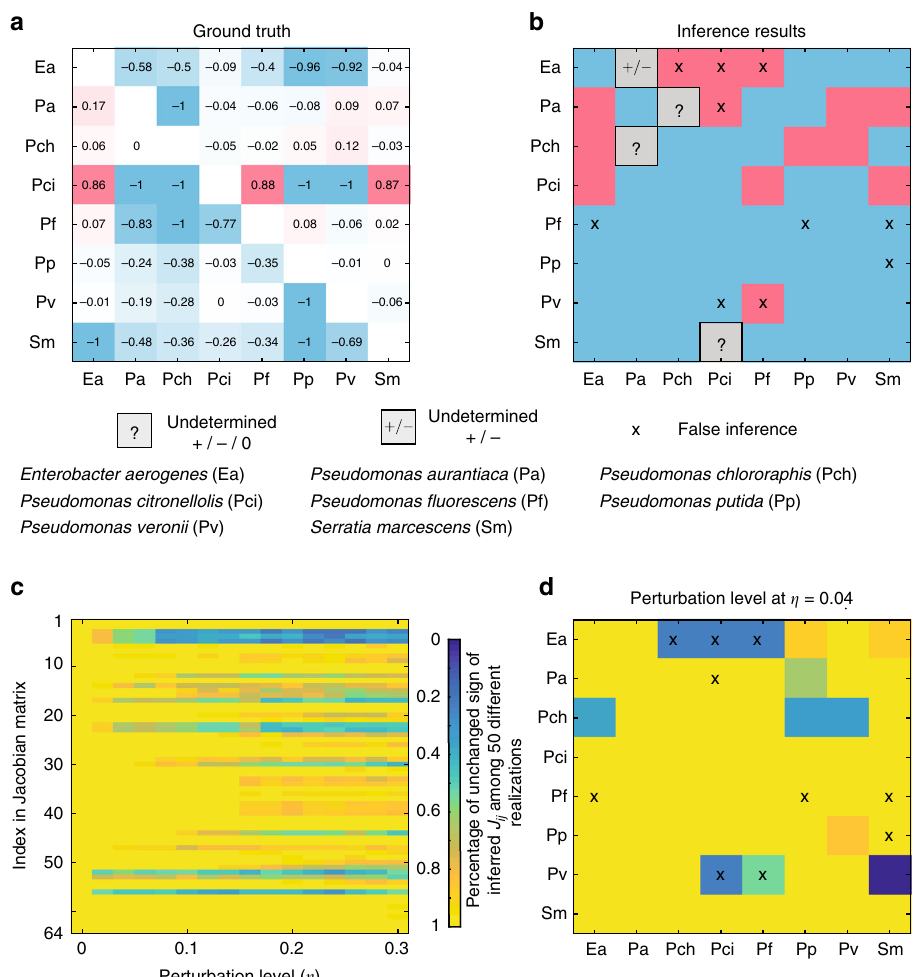
Fig. 5 Inferring interaction types of a synthetic soil microbial community. The steady-state samples were experimentally collected from a synthetic soil microbial community of eight bacterial species. Those steady-state samples involve 101 different species combinations: all eight solos, 28 duos, 56 trios, all eight septets, and 1 octet. a From the eight solos (monoculture experiments) and 28 duos (pair-wise co-culture experiments), one can calculate the relative yield R ij , quantifying the promotion (positive) or inhibition (negative) impact of species j on species i . The values shown in the relative yield matrix R ¼ ð R ij Þ quantify the strengths of promotion and inhibition effects. The sign-pattern of this matrix serves as the ground truth of that of the Jacobian matrix associated with the unknown population dynamics of this microbial community. b Without considering the 8 solos and 28 duos, we analyze the other steady-state samples. We use the brute-force method to infer the ecological interaction types, i.e., the sign-pattern of the Jacobian matrix. Blue (or red) means inhibition (or promotion) effect of species j on species i , respectively. 10 signs (labeled by ‘ × ’ ) are falsely inferred, four signs (gray) are undetermined by the analyzed steady-state samples. c , d The robustness of the inference results in the presence of arti fi cially added noise: x I i ! x I i þ η u , where the random number u follows a uniform distribution U ½(cid:4) x I i ; x I i (cid:8) , and η is the noise level. At each noise level, we run 50 different realizations. Yellow (or blue) means many (or few) inferred J ij keep the same sign among 50 different realizations. c . Many of the inferred J ij keep their signs in the presence of noise up to noise level η ¼ 0 : 3. d At η ¼ 0 : 04, we plot the percentage of unchanged signs for inferred Jacobian matrix in 50 different realizations. The ‘ × ’ labels correspond to the 10 falsely inferred signs shown in b . Five of the 10 falsely inferred interactions change their signs frequently even when the perturbation is very small, implying that the falsely inferred signs in b could be due to measurement noise in the